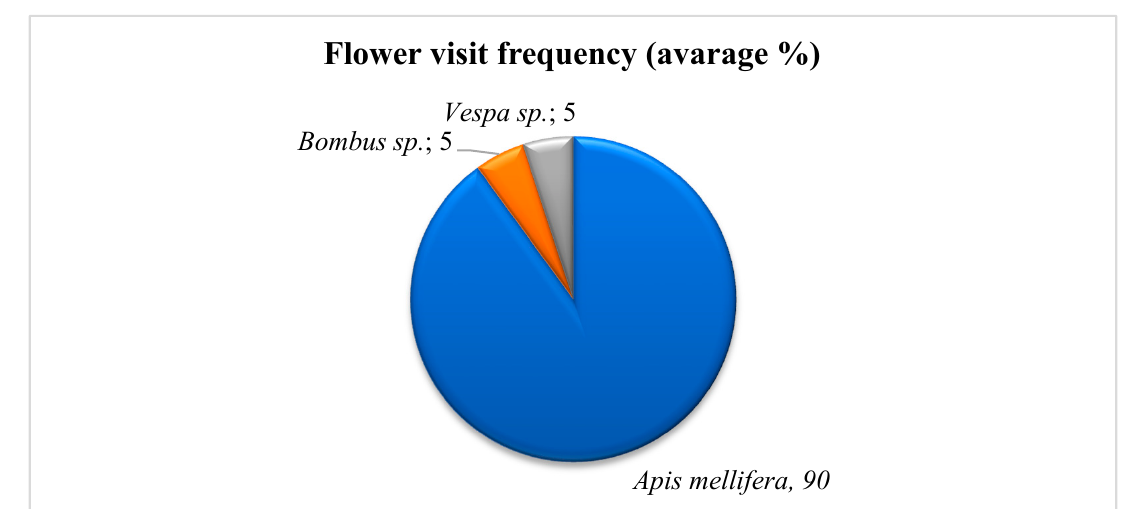
Figure 5. Frequency of insect visits to flowers of F. aurea based on video recordings.